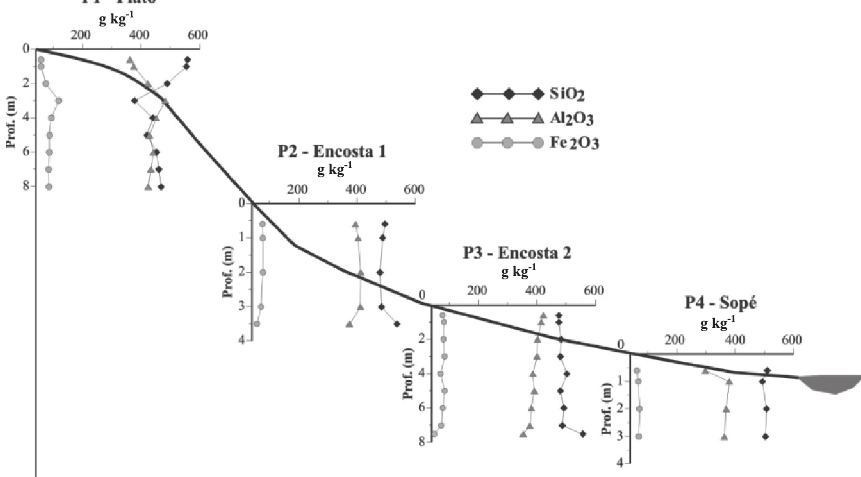
Figura 2. distribuição dos teores de sio 2 , al 2 o 3 e Fe 2 o 3 nos pontos localizados em paisagens distintas da microbacia.